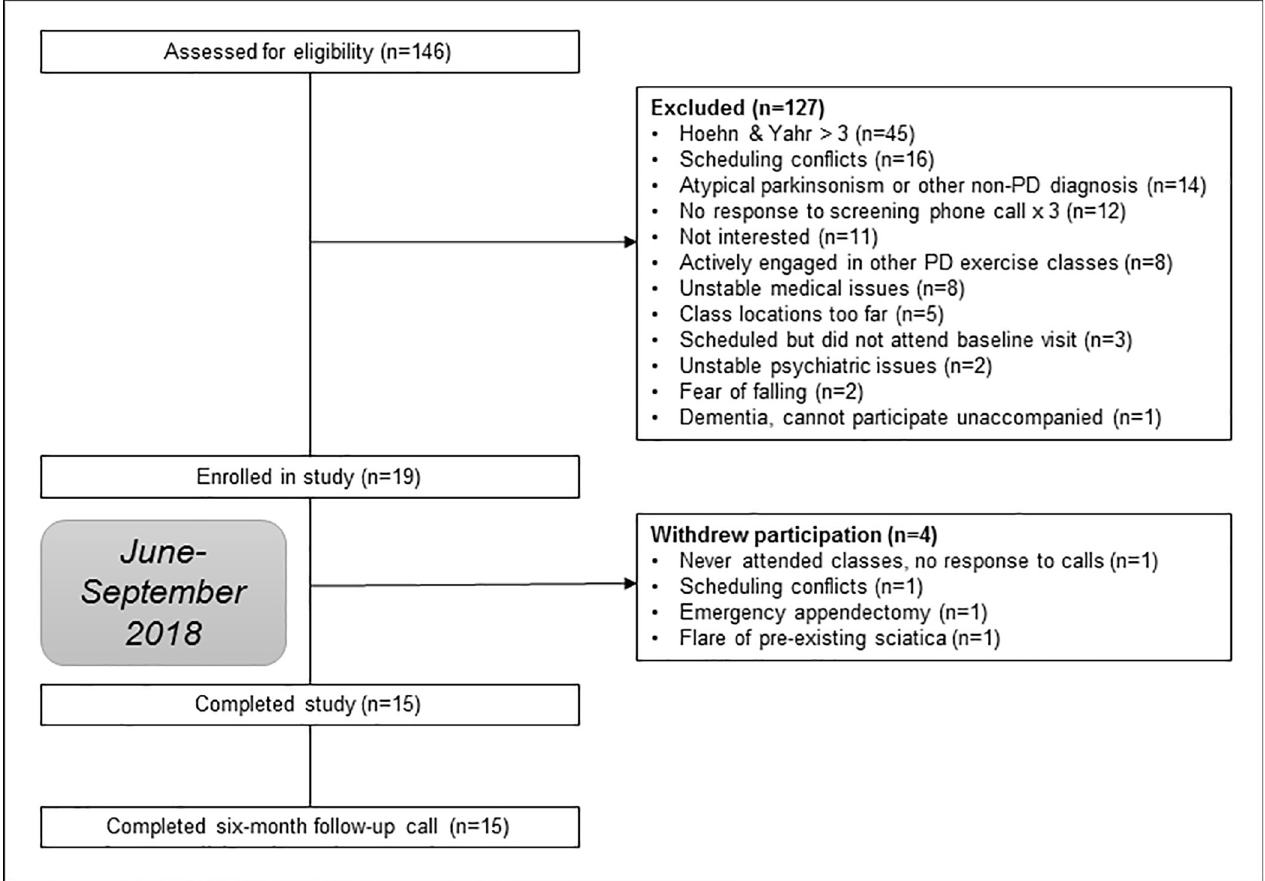
Fig 1. Study flow diagram. Study flow diagram demonstrating potential participants screened for eligibility, participants enrolled and completing the study, and reasons for ineligibility or exclusion.